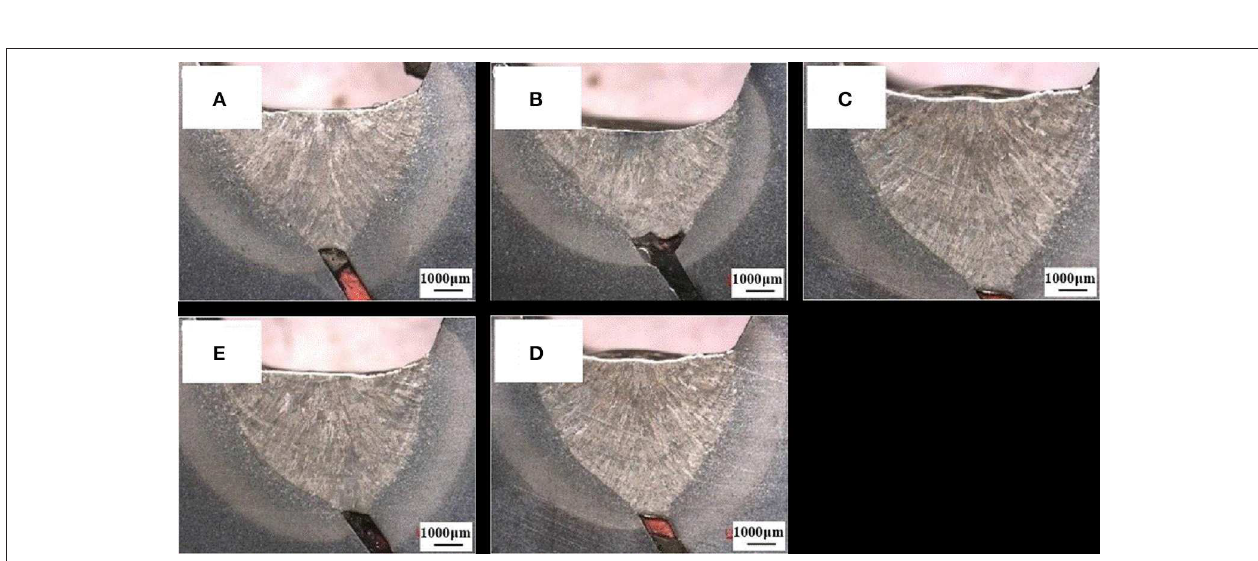
FIGURE 6 | Macrograph of the weld line cross-section of a test sample preheated to 50 ◦ C. (A–E) Show from the initial end to the crater.